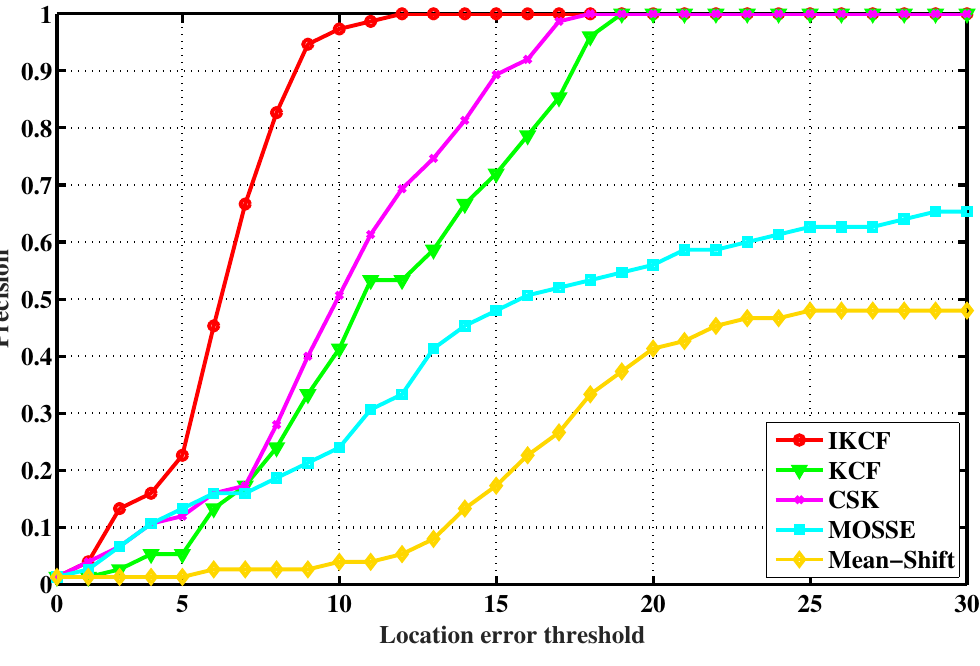
Figure 10. Location error precision curves (1082nd frame to 1152nd frame).